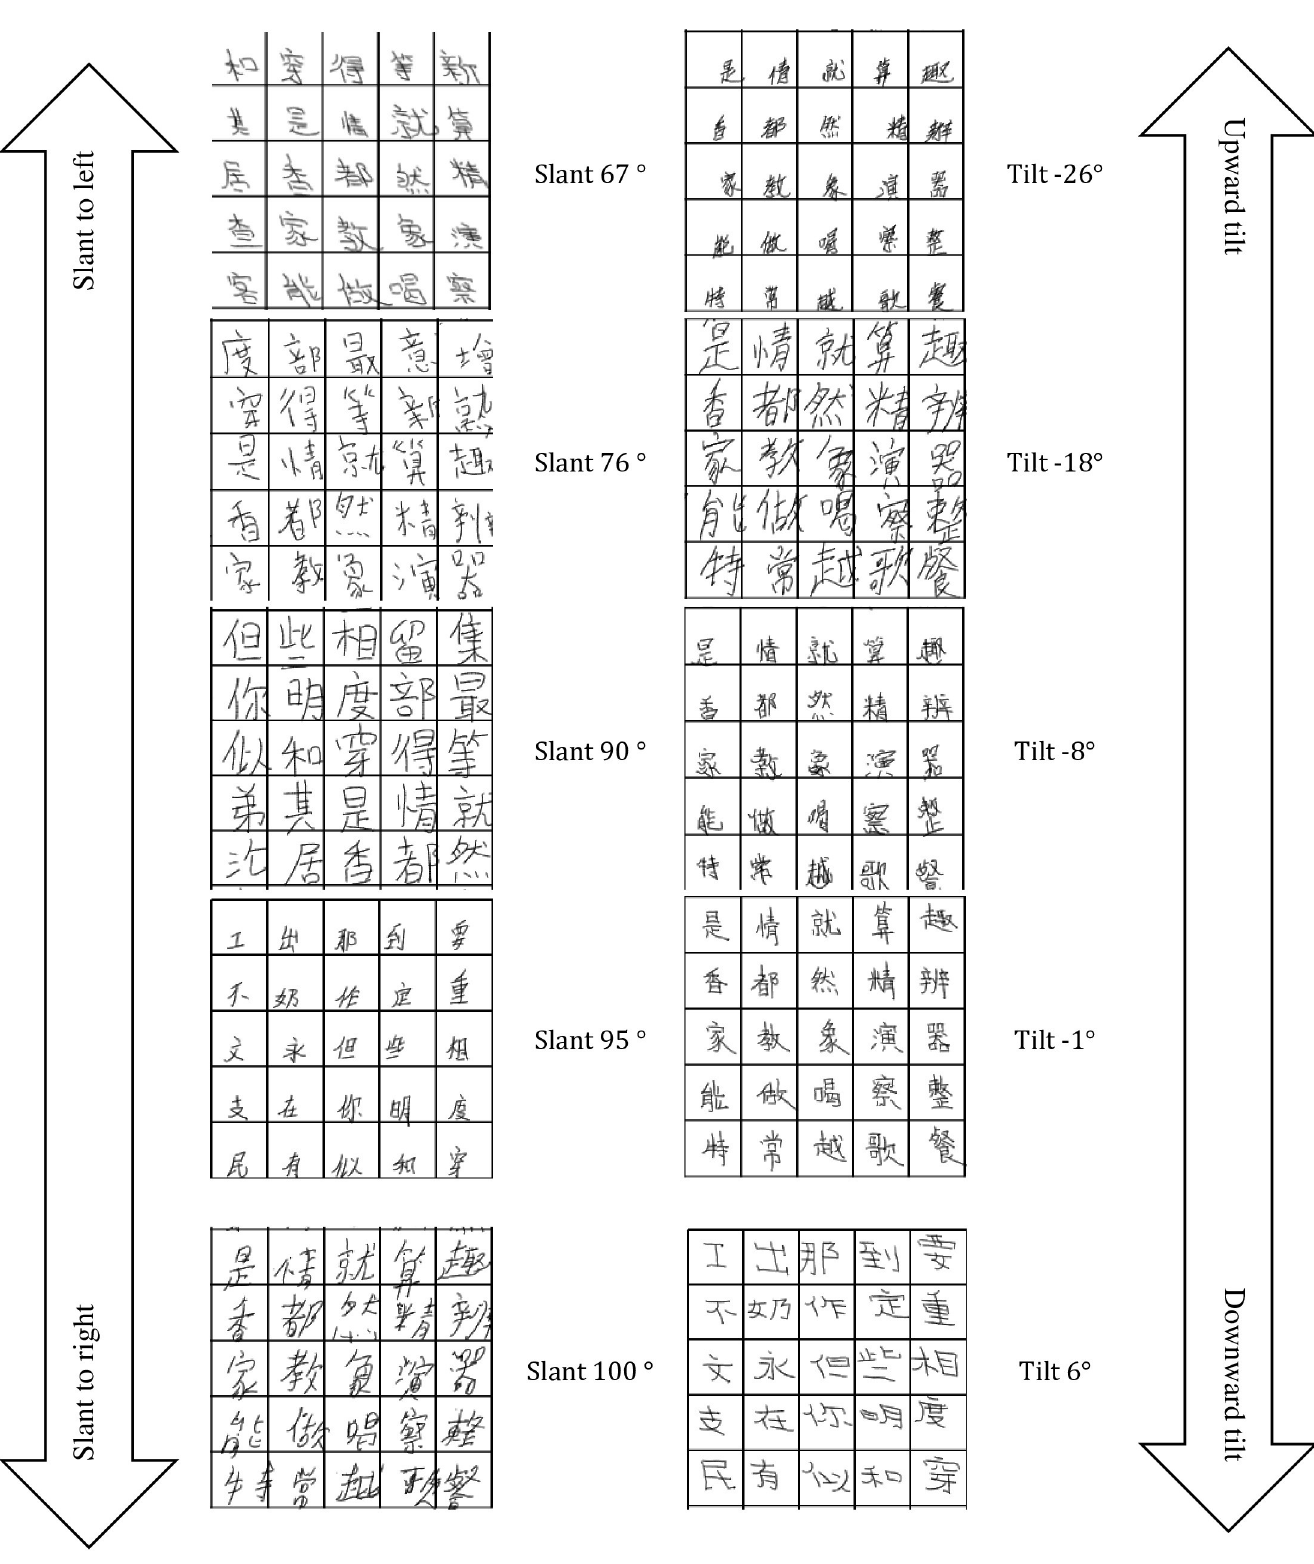
Fig 6. Tilt and slant assessment